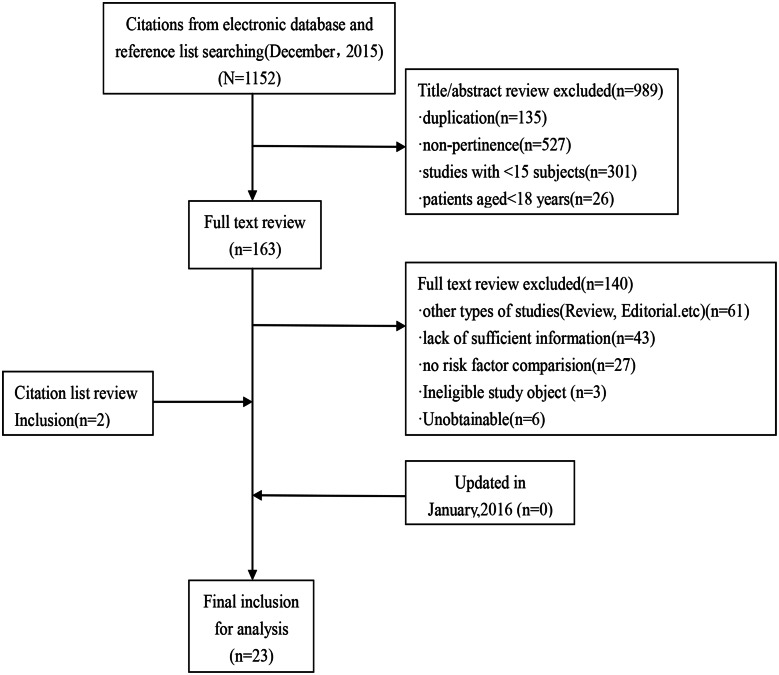
A flow diagram of the studies.